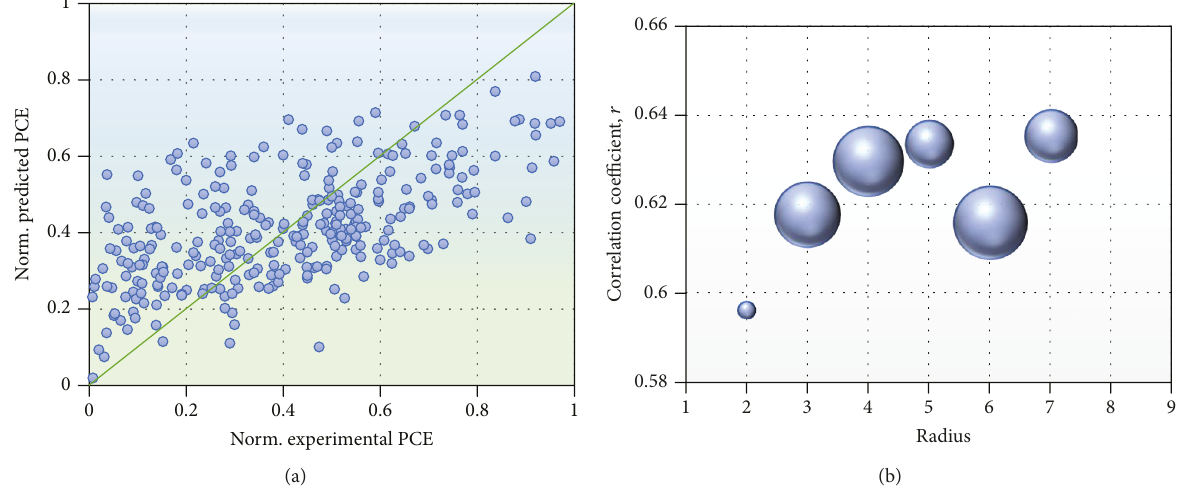
Figure 2: (a) The predictive result of the SVM model; the radius ( r ) of the Morgan fi ngerprint was two. Note that the experimental and predicted PCE values have been normalized. The diagonal line implies the positive perfect correlation ( R = 1 ). (b) E ff ect of the Morgan radius on the performance of the SVM model. Note that the diameter of each bubble represents the relative size in quantity for the standard derivatives of the correlation coe ffi cients.